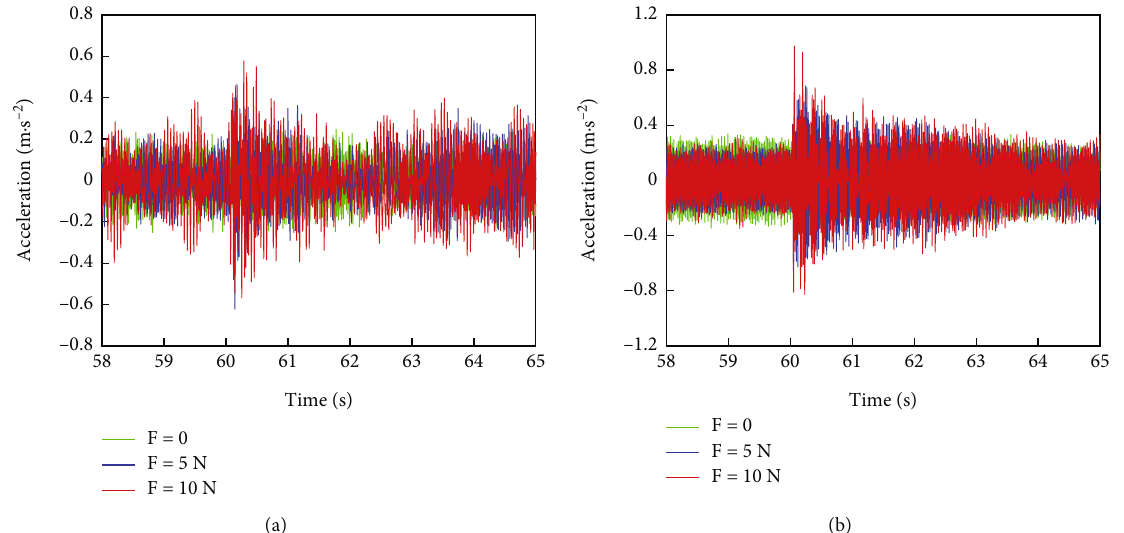
Figure 14: Acceleration response with multichannel LMS at secondary path mutation (58-65s). (a) 1# point. (b) 2# point.